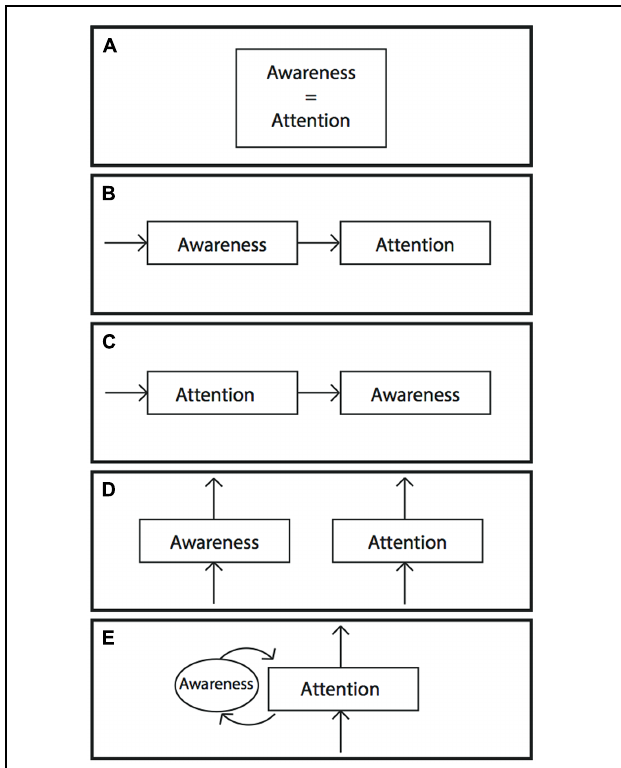
FIGURE 3 | Five possible hypotheses about the relationship between awareness and attention. (A) Awareness and attention are the same. (B) Awareness precedes attention. One must become aware of something before attending to it. (C) Attention precedes awareness. One must attend to something before it can enter awareness. (D) Awareness and attention are independent processes in the brain. (E) The hypothesis proposed in the present article. In the attention schema theory, awareness is part of the control machinery for attention. It is the internal model of attention, the attention schema. Without awareness, attention is still possible but suffers from deficits in